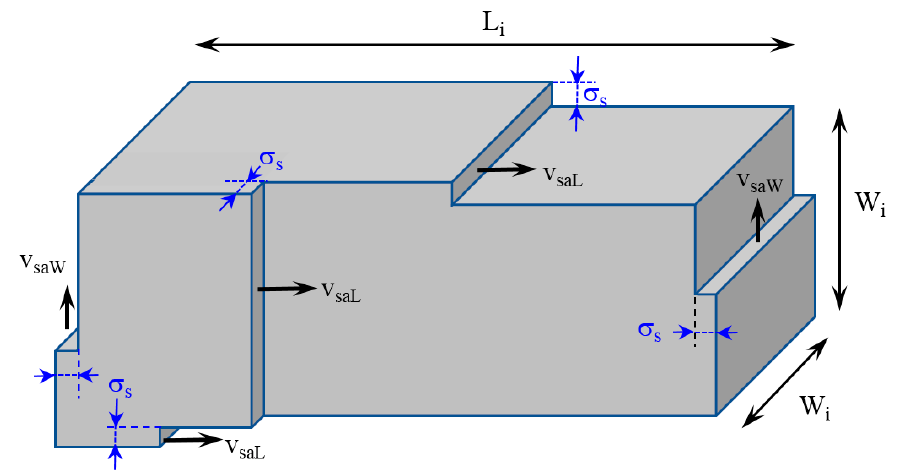
Figure 3. Crystals with two characteristic faces and propagating steps on each face.